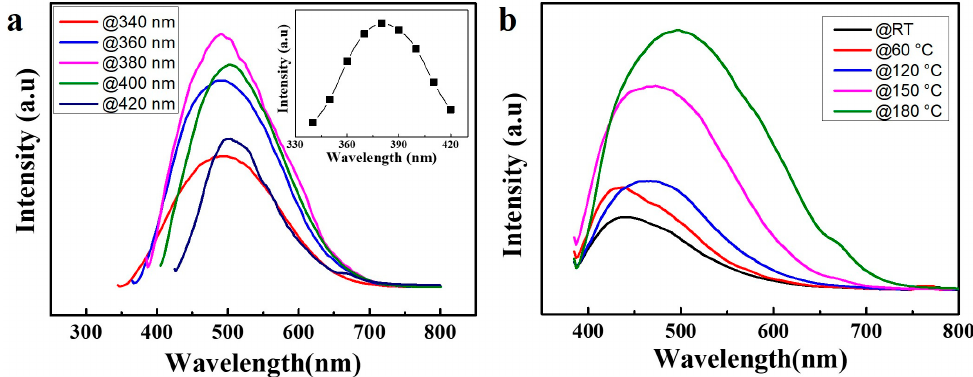
Figure 3. ( a ) PL spectra of WSe 2 QDs after thermal treatment temperature of 180 ◦ C. The inset is the excitation spectra of WSe 2 QDs after thermal treatment temperature of 180 ◦ C for 16 h. ( b ) PL spectrum of as-prepared samples at different thermal treatment temperatures at 380 nm excitation.